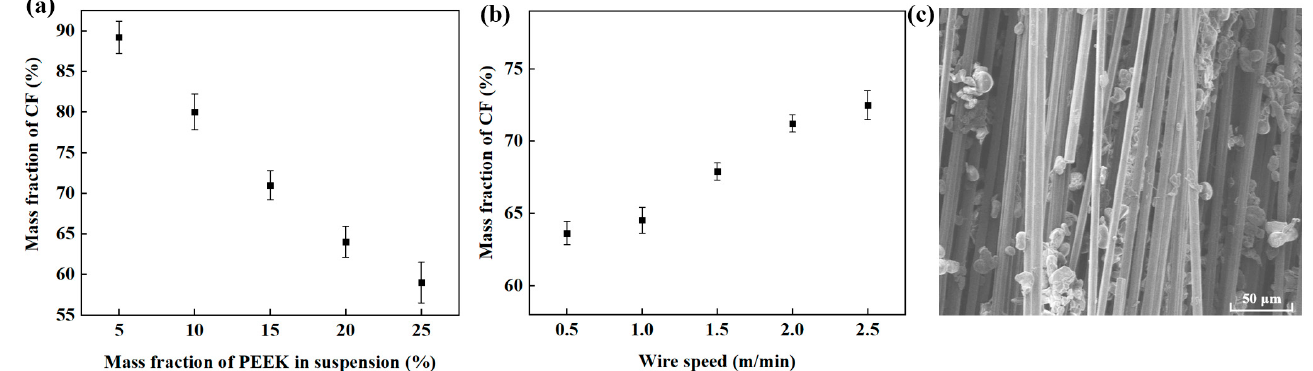
Figure 2. Effects of ( a ) PEEK powder mass fraction and ( b ) wire moving speed on the CF mass fraction in the powder impregnation process. ( c ) SEM image of CF after powder impregnation.